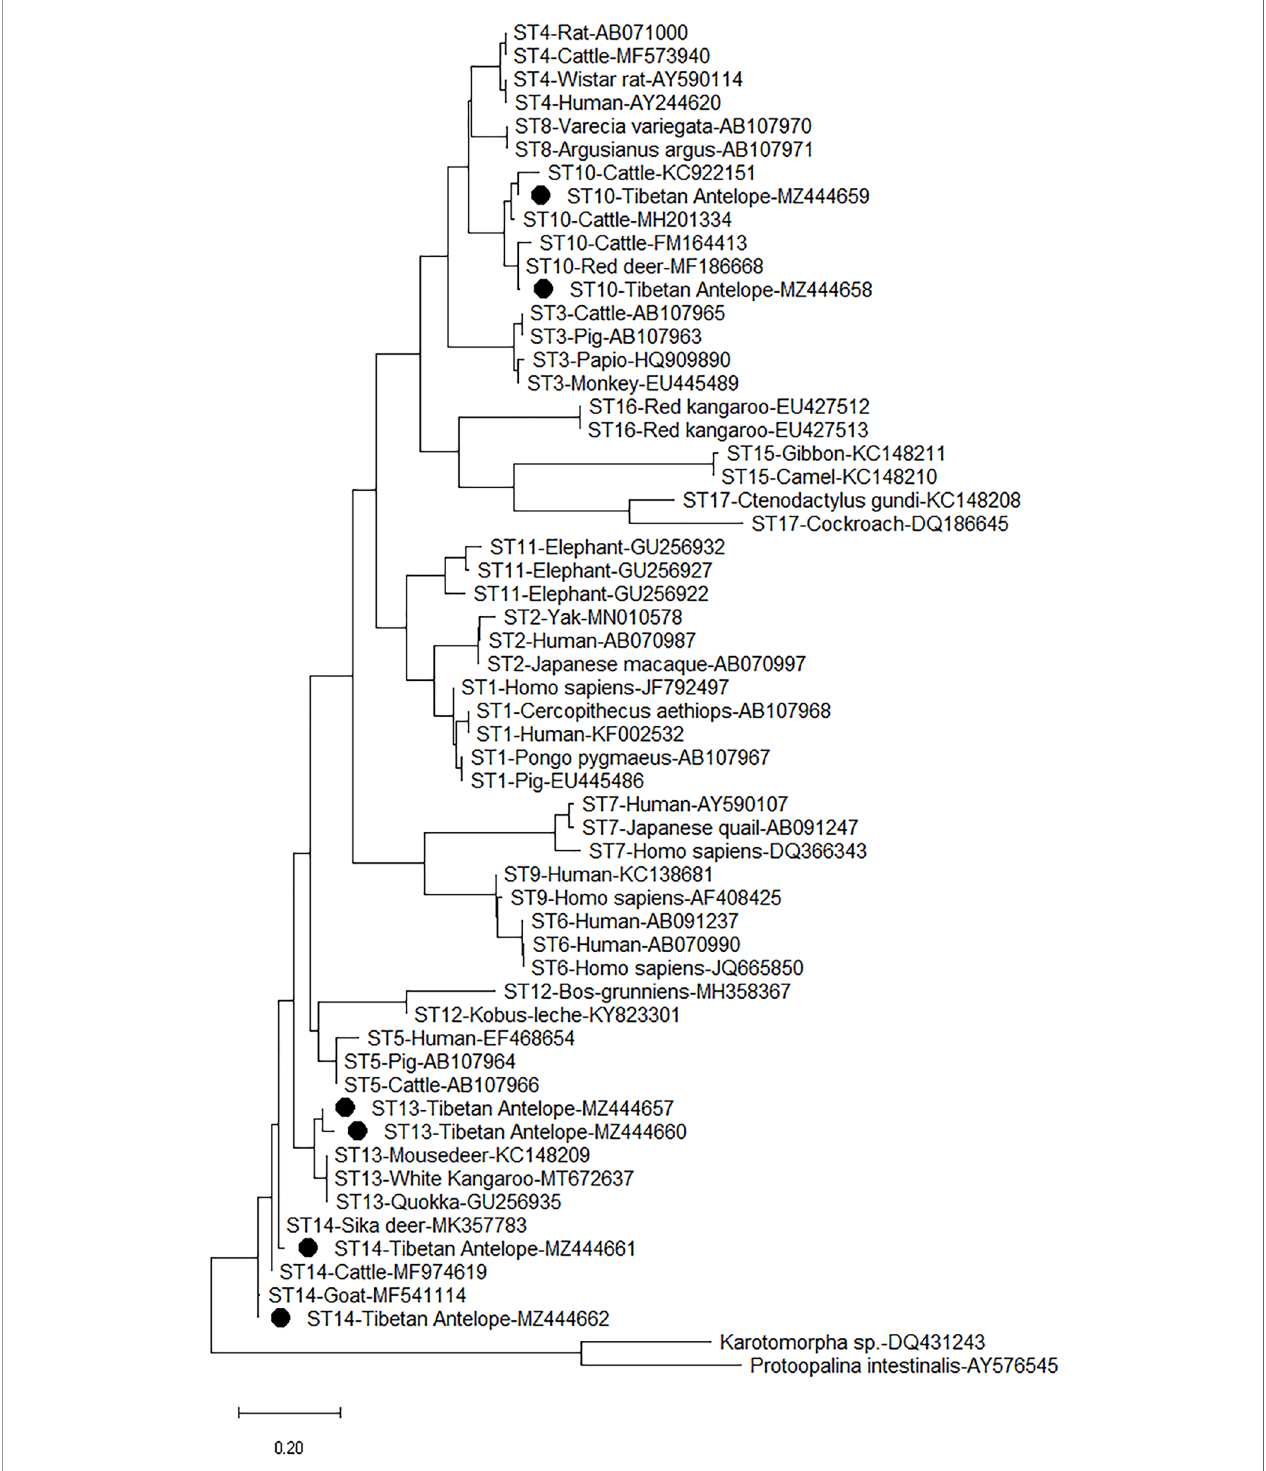
FIGURE 3 | Phylogenetic analyses of Blastocystis using (ML) method (Kimura two-parameter model). Bootstrap values below 50% from 1,000 replicates are not shown. Blastocystis isolates identi fi ed in the present study are indicated by solid circles.